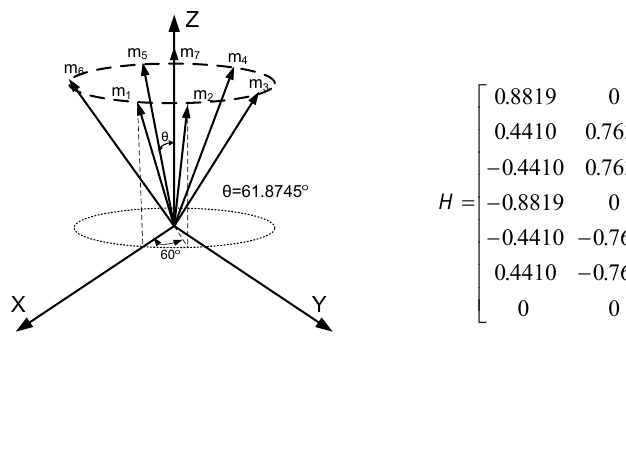
Figure 3. Configuration 2 of seven inertial